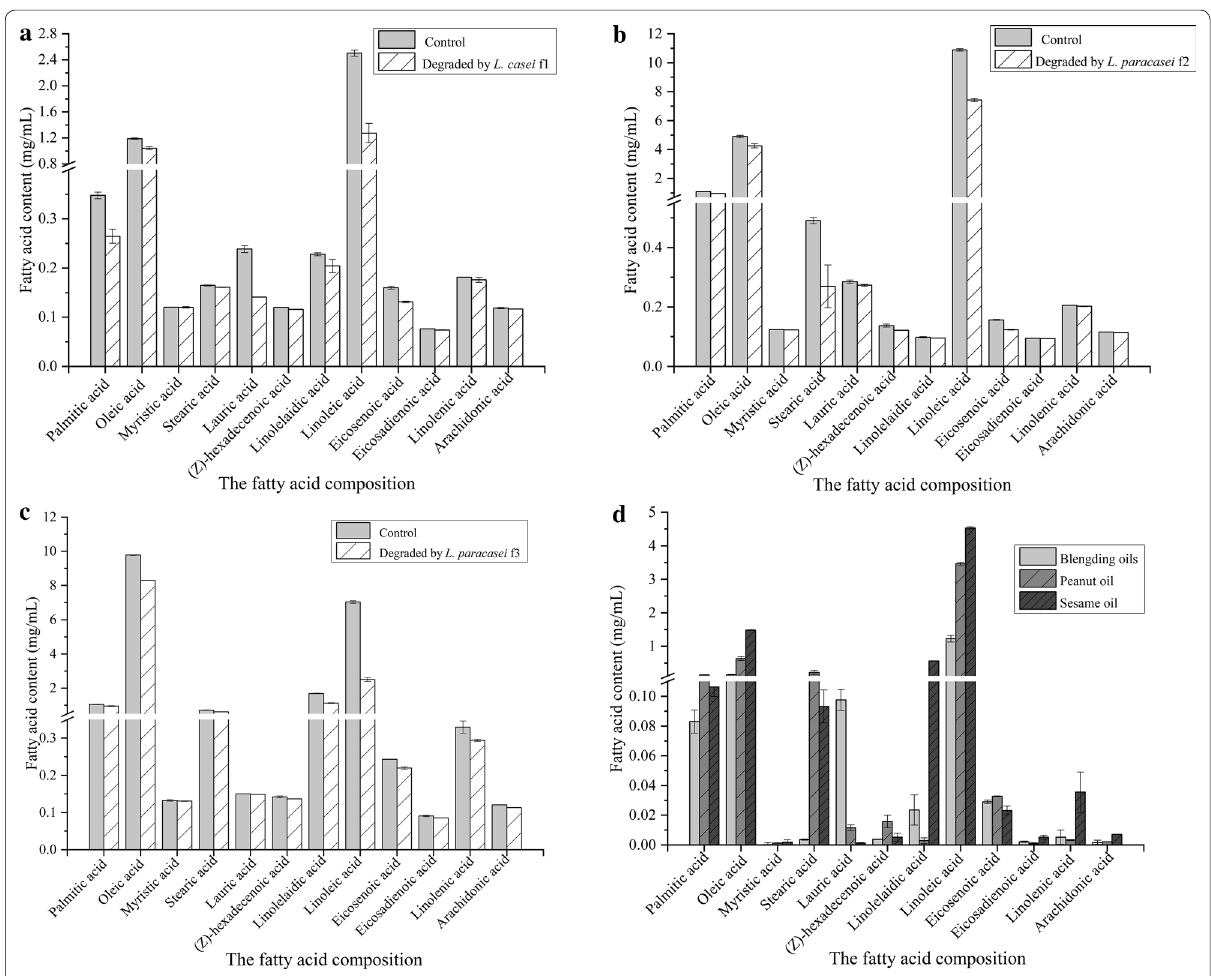
Fig. 5 The fat acids of the preferred oils degraded by the isolated strains. To detect the degraded fat acids of the oil, L. casei f1 ( a ), L. paracasei f2 ( b ) and L. paracasei f3 ( c ) were separately cultivated for 48 h in the mineral medium containing the blending oils, peanut oil and sesame oil as the solo carbon source, respectively. The variation of the fat acids in each sample was analyzed ( d ). Data are presented as mean represents standard errors of mean